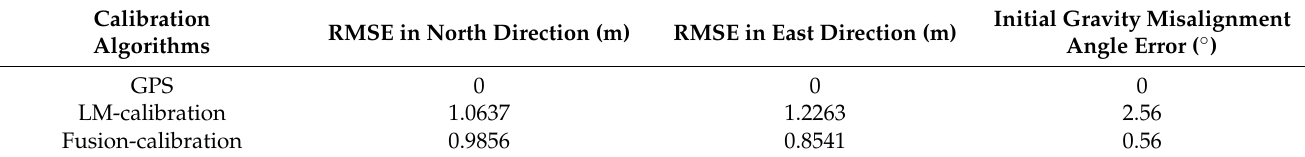
Table 11. Vertical comparison error and horizontal comparison error.